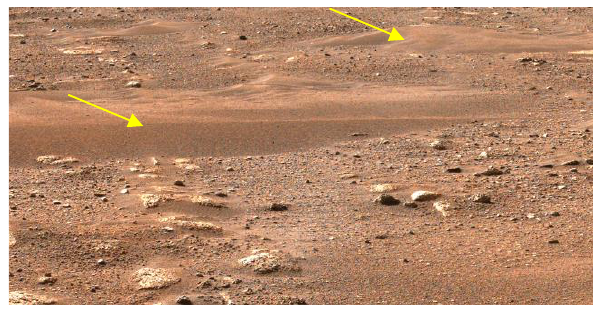
Figure 20. Mastcam-Z image recorded on Sol 11. Few boulders and luminance variations can be